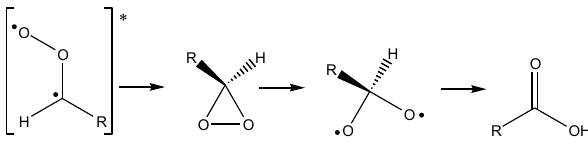
Scheme 2. A schematic diagram of the formation of HC(O)OH un- der dry